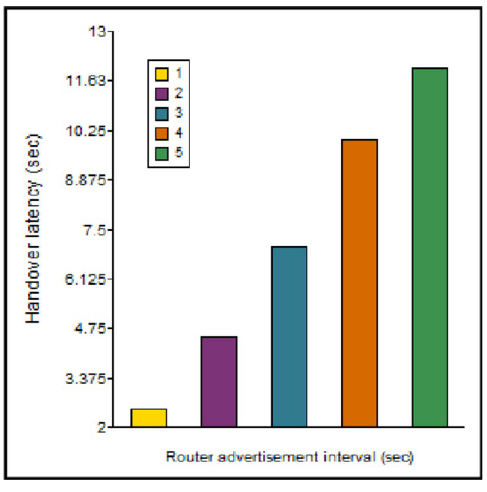
Fig 13. Handover latency vs. RA interval.